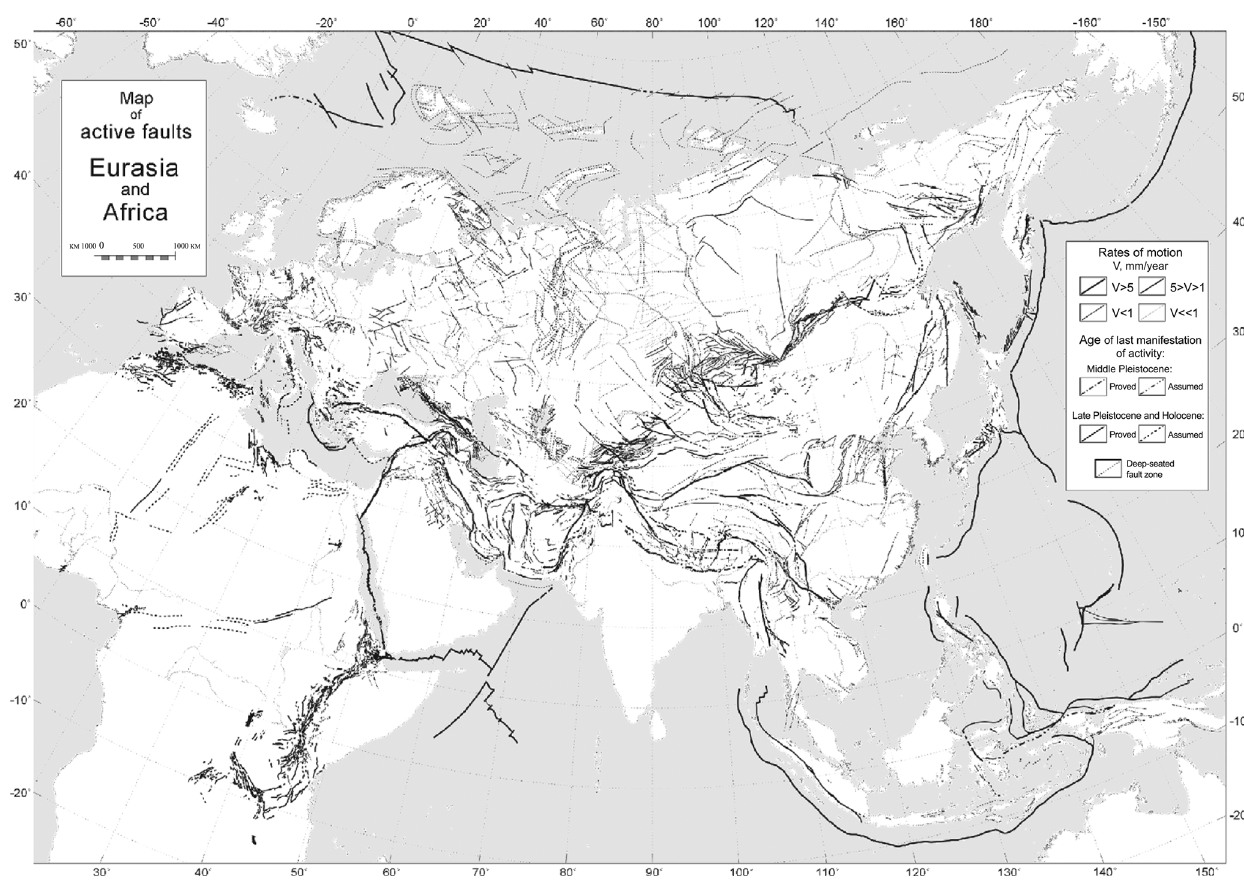
Figure 3. A selection from the World Map of Major Active Faults for Eurasia and Africa (Trifonov,